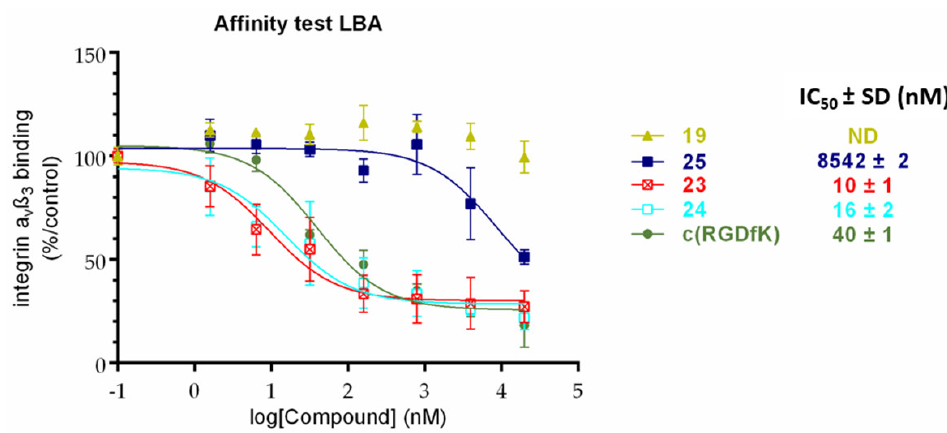
Figure 2. Solid-phase binding assay. Effect of compounds 23 and 24 on the binding of α v β 3 integrin onto vitronectin compared to c (RGDfK) reference.